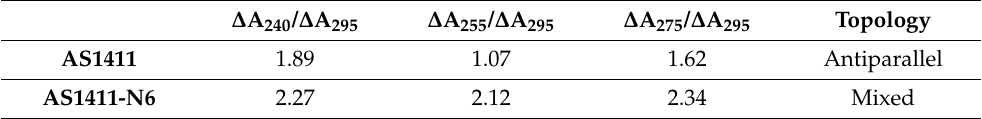
Table 1. Topology characterization of AS1411 and AS1411-N6 according to reference TDS values.